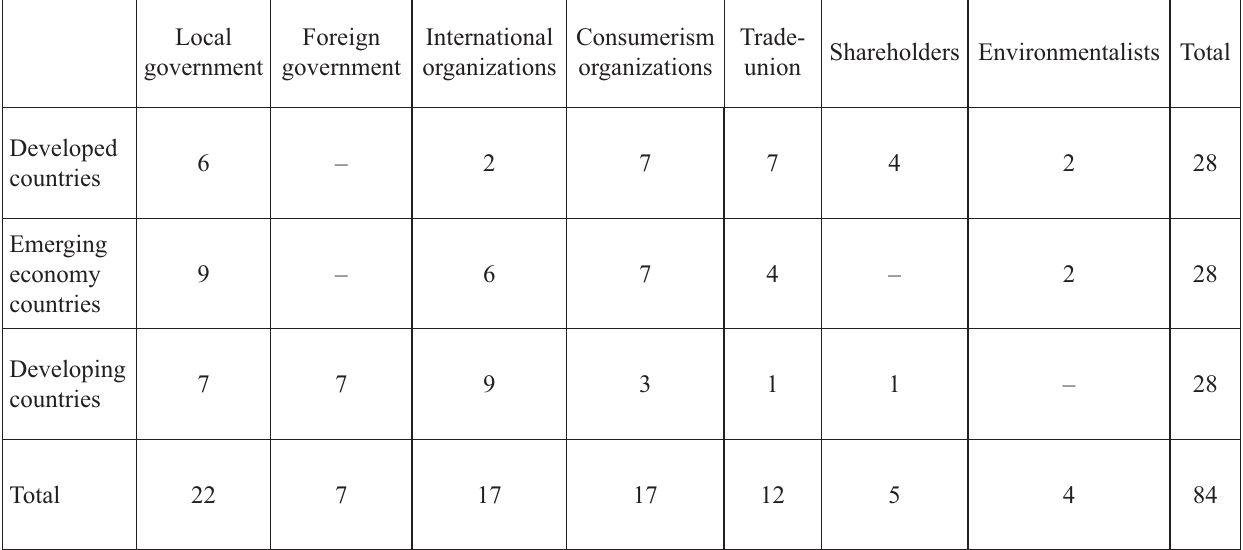
Table 1. Frequency of documents by stakeholders and economic development of the country